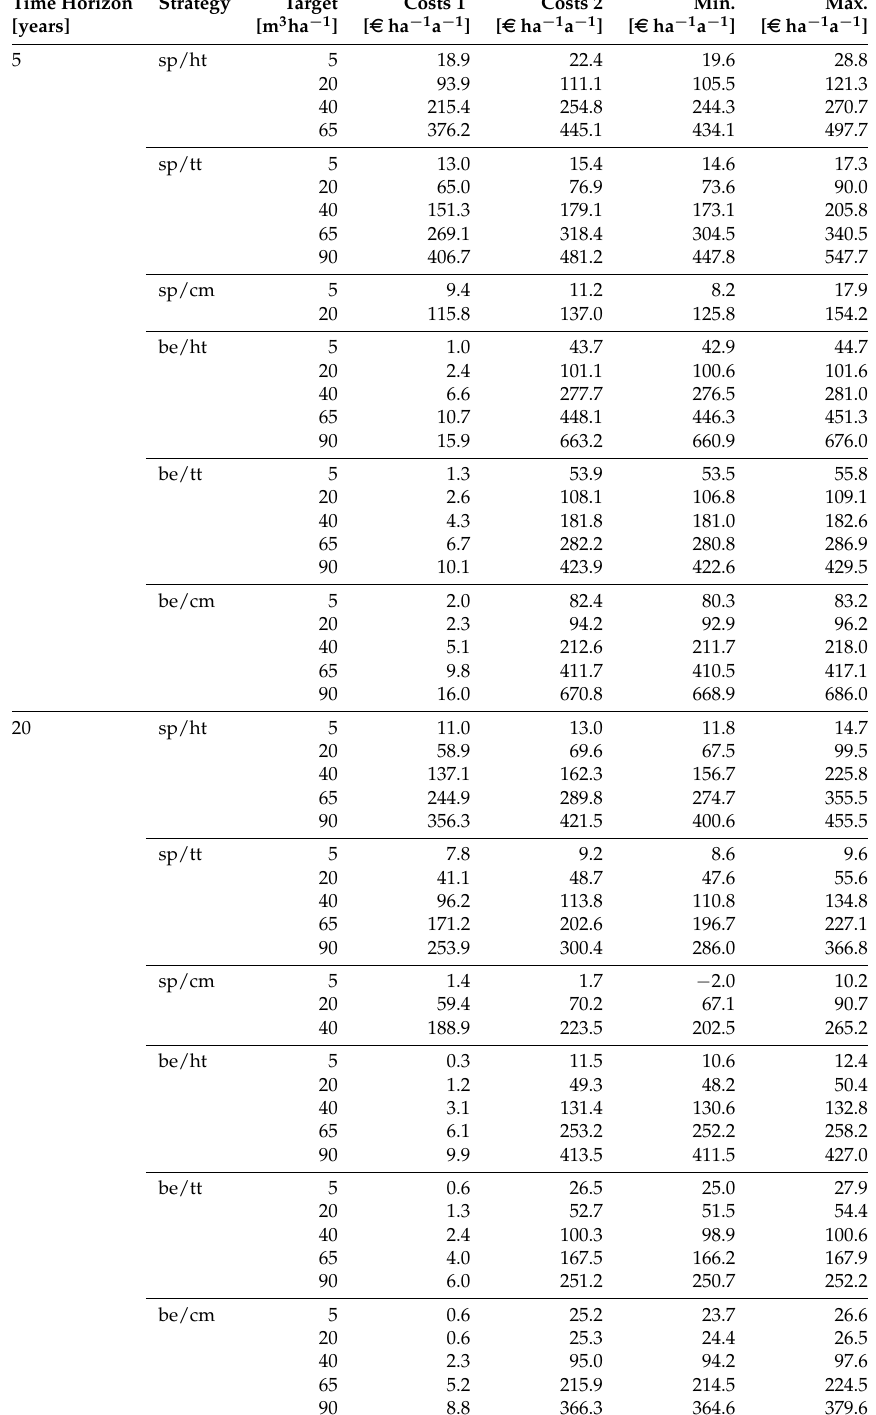
Table 5. Forest enterprise “Neureichenau”: Median costs and influence of the degree of segregation. The single strategies are abbreviated as shown in Table 3. Costs 1 shows the costs as the loss of annuity within the enterprise, while Costs 2 shows the costs related to the area of the individual tree species of the scenario. The Min. column shows the result for 100 % segregation, the Max. column the result for 1 %